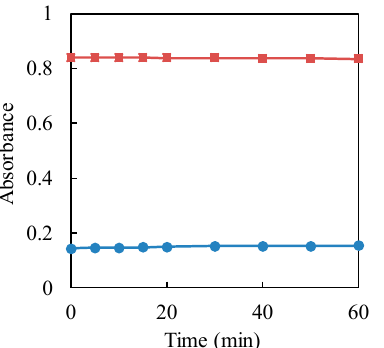
Figure 2. E ff ect of standing time on the absorbance of the complex between Cr(VI) and Figure 2. Effect of standing time on the absorbance of the complex between Cr(VI) and 1,5- Figure 2. Effect of standing time on the absorbance of the complex between Cr(VI) and 1,5- 1,5-diphenylcarbazide. Cr(VI) concentration: Circle (blue) 10 µ g · mL − 1 ; square (red): 50 µ g · mL − Figure 2. Effect of standing time on the absorbance of the complex between Cr(VI) and 1,5- diphenylcarbazide. Cr(VI) concentration: Circle (blue) 10 μ g·mL − 1 ; square (red): 50 μ g·mL − 1 . diphenylcarbazide. Cr(VI) concentration: Circle (blue) 10 μ g·mL − 1 ; square (red): 50 μ g·mL − 1 . diphenylcarbazide. Cr(VI) concentration: Circle (blue) 10 μ g·mL − 1 ; square (red): 50 μ g·mL − 1 .